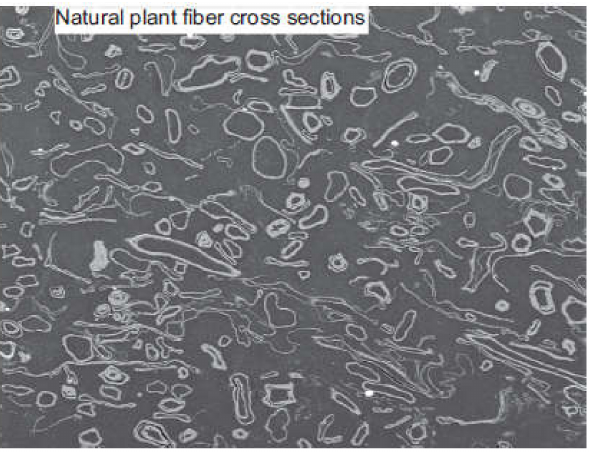
Figure 12. A natural plant fiber cross-section